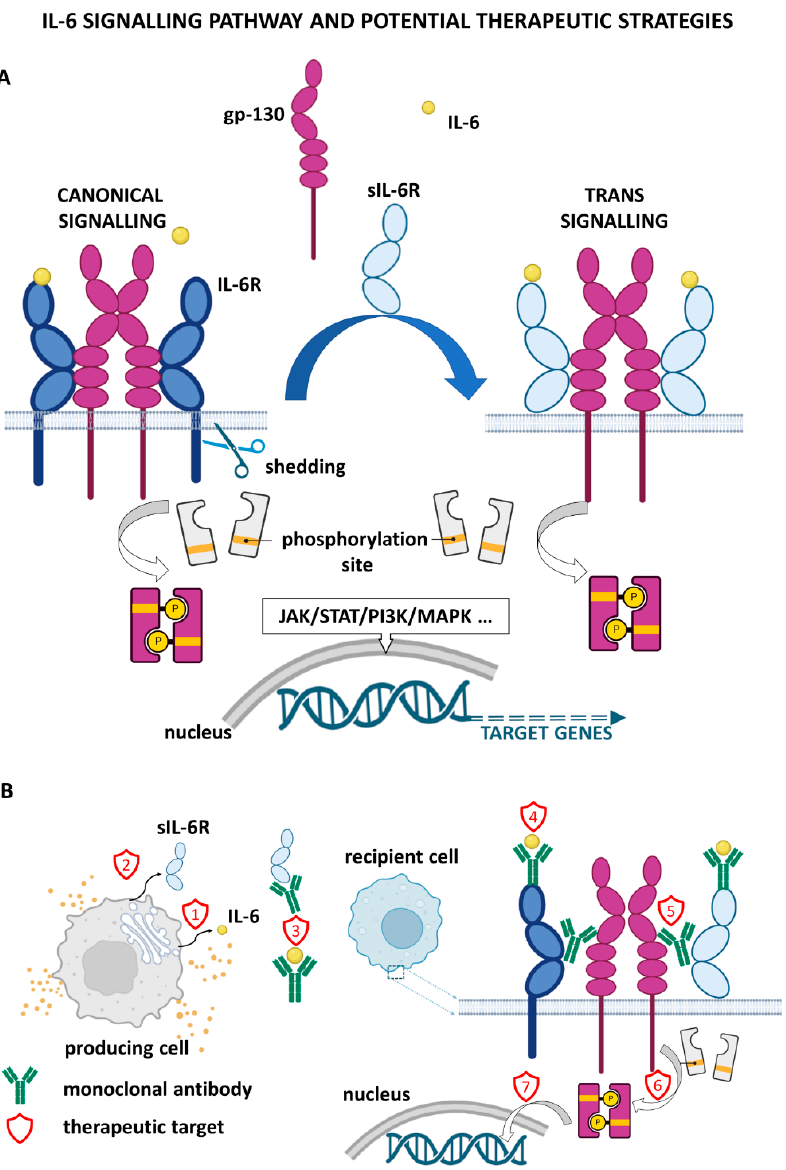
Figure 5. Therapeutic strategies for the inhibition of IL-6 signalling.( A ) intracellular signaling, ( B )intercellular signaling. (1) cytokine synthesis/release blockade, (2) sIL-6R shedding blockade, (3) cytokine/soluble receptor neutralizing, (4) cytokine binding to receptor prevention, (5) heterotetrameric complex formation blockade, (6) signal transducer kinase activity inhibition, (7) downstream signalling blockade/gene transcription blockade. Table 1. Examples studied agents for the inhibition of IL-6 signalling with an emphasis on their clinical applicability.